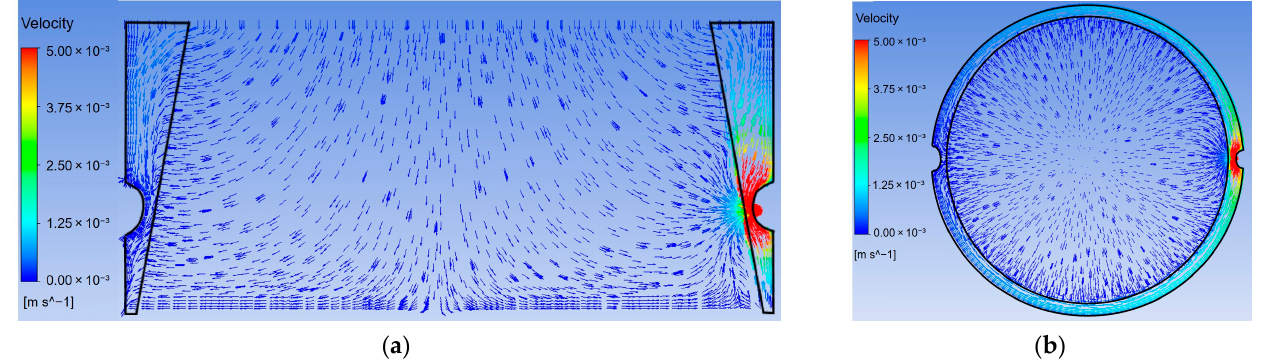
Figure 3. ( a ) Iron flow field in the xz cross section through the taphole line and ( b ) iron flow field in the xy cross section with 1.5 m height from the hearth bottom. The CFZ is marked by black lines.